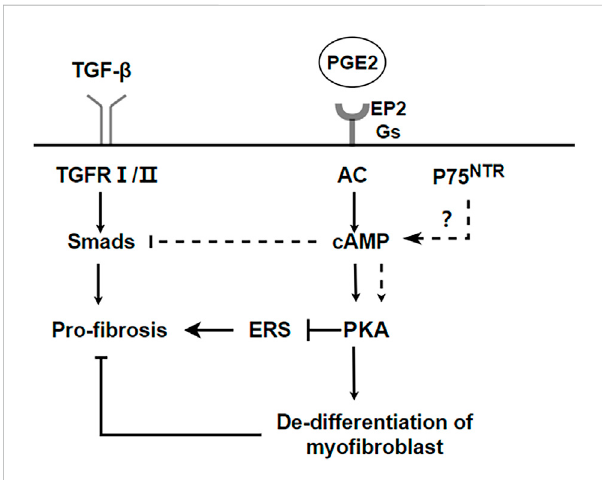
FIGURE 3 PKA pathways inhibit the process of IPF. cAMP/PKA can inhibit endoplasmic reticulum stress and promote dedifferentiation of myo fi broblasts to realize anti- fi brosis. p75 NTR regulates tissue fi brosis through inhibition of plasminogen activation via a PDE4/cAMP/ PKA pathway. But it needs to be further veri fi ed in pulmonary fi brosis.